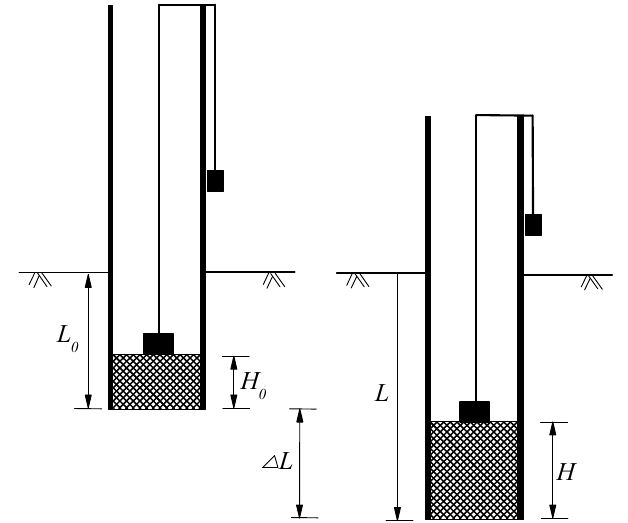
Figure 5. Measurement of soil plug length during pile jacking.